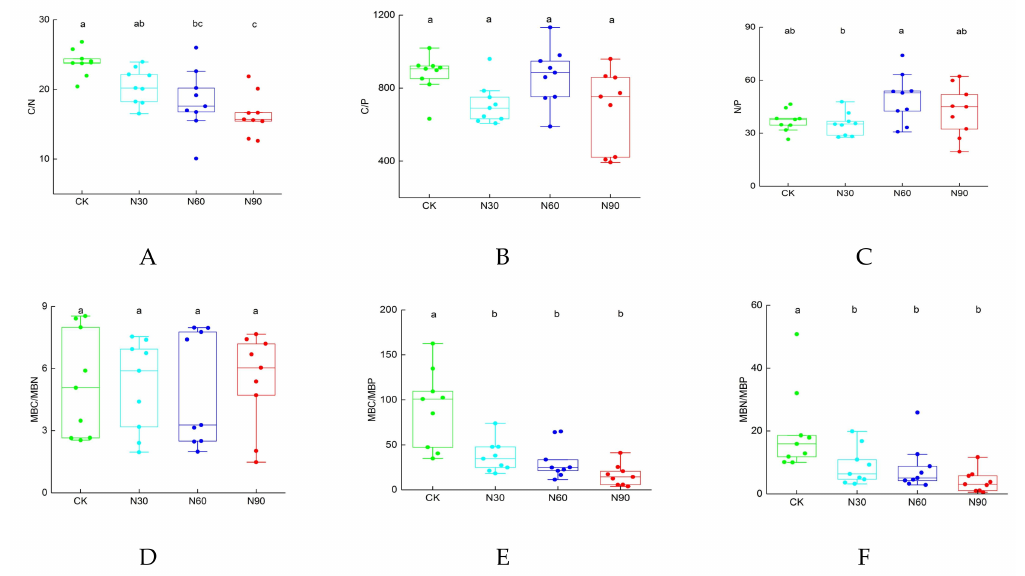
Figure 1. ( A – C ) Box plot of multiple comparative analysis of soil stoichiometries, i.e., C / N, C / P and N / P, using the Tukey method among di ff erent SND levels (CK, N30, N60 and N90). ( D – F ) Box plot